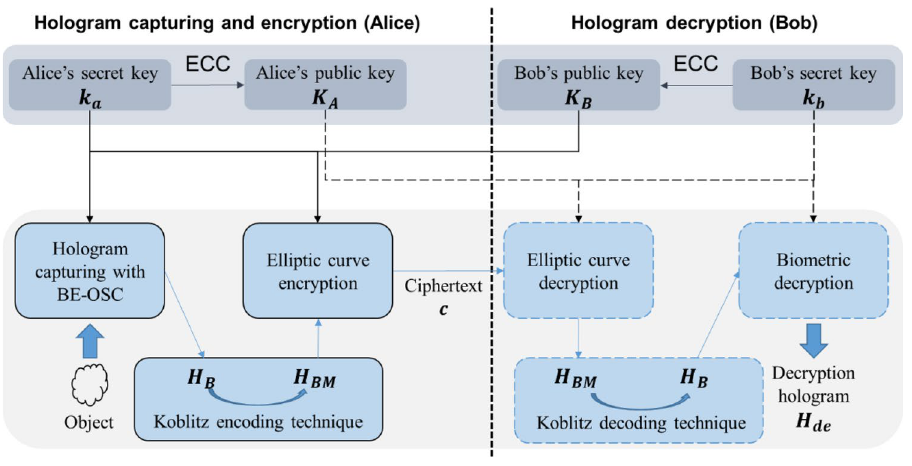
Figure 2. Block diagram of our proposed